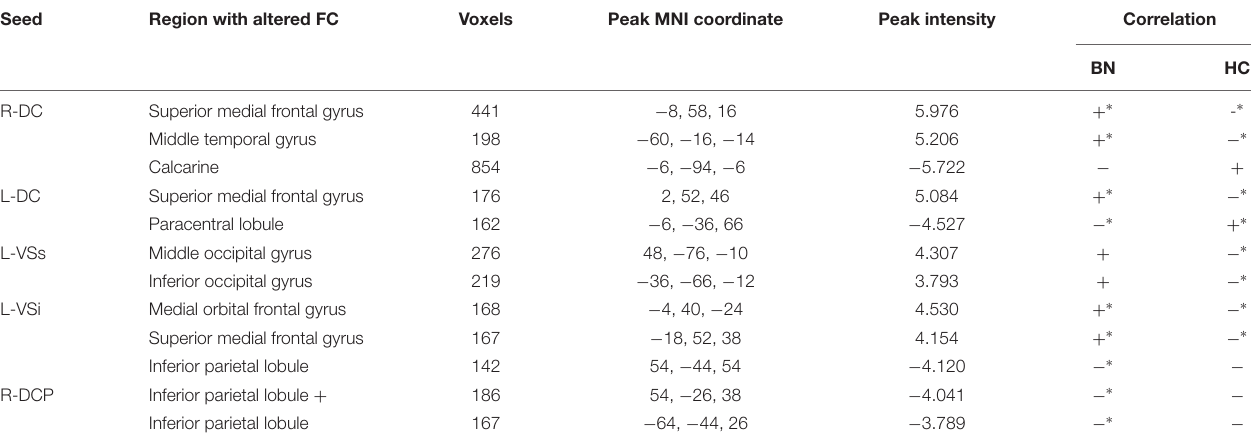
TABLE 2 | Between-group differences (insomnia vs. healthy control) in striatal connectivity. Seed Region with altered FC Voxels Peak MNI coordinate Peak intensity Correlation